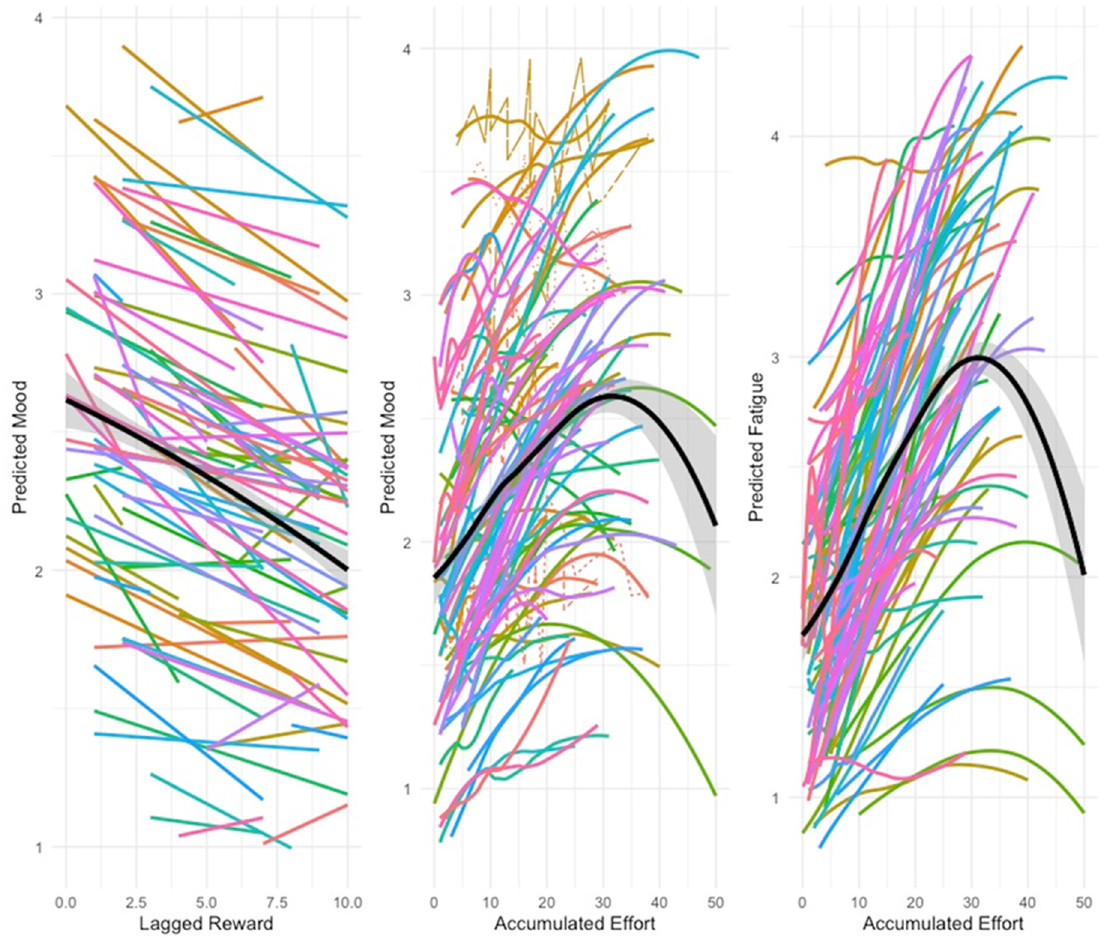
Figure 3. Spaghetti plots of fitted models with quadratic trend variables. Every line represents an individual’s trajectory, and the bold black lines represent the smooth means, with the 95% confidence intervals in grey.